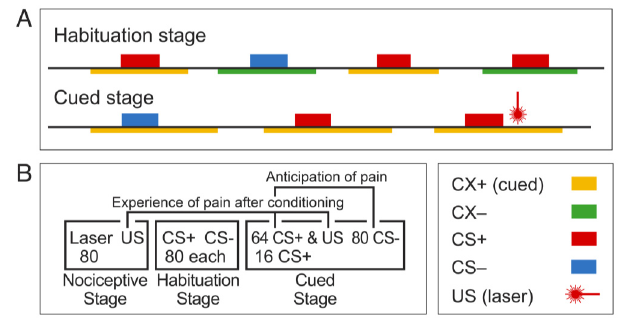
Figure 1. Aversive Conditioning Protocol: ( A ) Cartoon of stages including the cued stage composed of a train of visual stimuli in which an unconditioned stimulus (US—painful laser pulse) is paired with one conditioned light stimulus in 75% of trials (CS + , image of a lamp lighted red signaling threat—80 total (see Panel B), while the second light is not paired (CS − , lamp lighted blue signaling safety—80), and the CS + and CS − are presented randomly in the cued context (CX + , yellow underline, image of an o ffi ce with lamp as above). CX, green underline is the extinction context, not reported here. After pairing of stimuli, the CS + elicits a conditioned response (CR) including the Skin Conductance Response (SCR) and the ratings described below. The protocol is randomized for the (i) order of CSs and pairing of CS + and US (ii) duration (within limits) of intertrial intervals, CSs, CXs, and CX onset to onset of CS. ( B ) Each stage has 2 blocks. The protocol begins with 2 blocks in the Nociceptive Stage (total of 80 stimuli) followed by the Habituation stage (160 CSs total). Ratings are performed in all intervals between blocks, and after the protocol. Anticipation is measured by the contrast between CS + vs. CS − in the Cued Stage; experience of cued pain is measured by the contrast of US between the Cued vs. the Nociceptive Stage, and the US skin conductance response (SCR) following CS + vs. CS − in the cued stage. This Figure is adapted from [12].